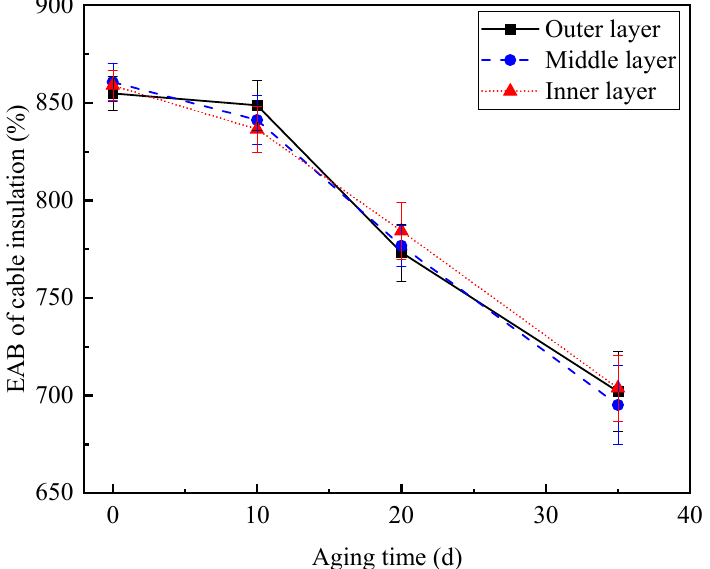
Figure 6. EAB and the corresponding variance of aging cable insulation in different positions versus the aging time.